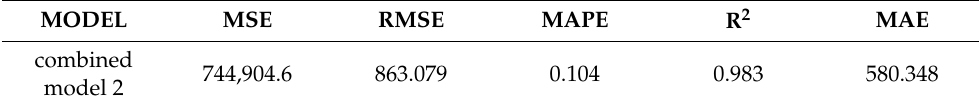
Figure 9. Comparison of the SVR model, combined model 2, and the true value of India. Table 6. Validation Metrics of the combined model 2 for the epidemic data of